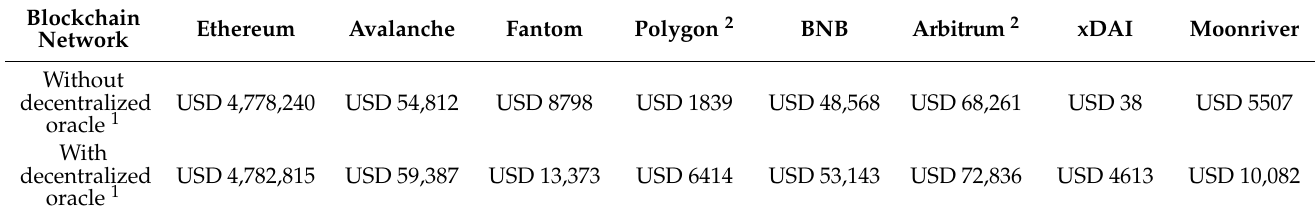
Table 4. The total price of execution of the BCDT smart contracts for the use-case project lifecycle with a decentralized oracle (Chainlink) and without a decentralized